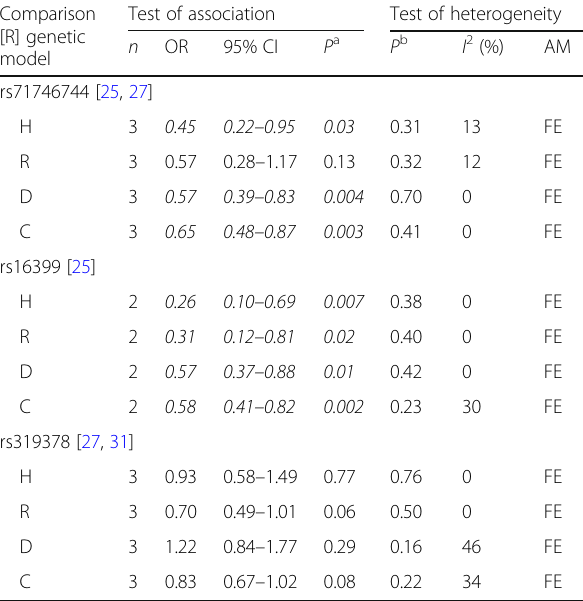
Table 4 Summary outcomes of associations in rs71746744, rs16399, and rs3196378 COL5A1 polymorphisms with tendon injury Comparison [R]